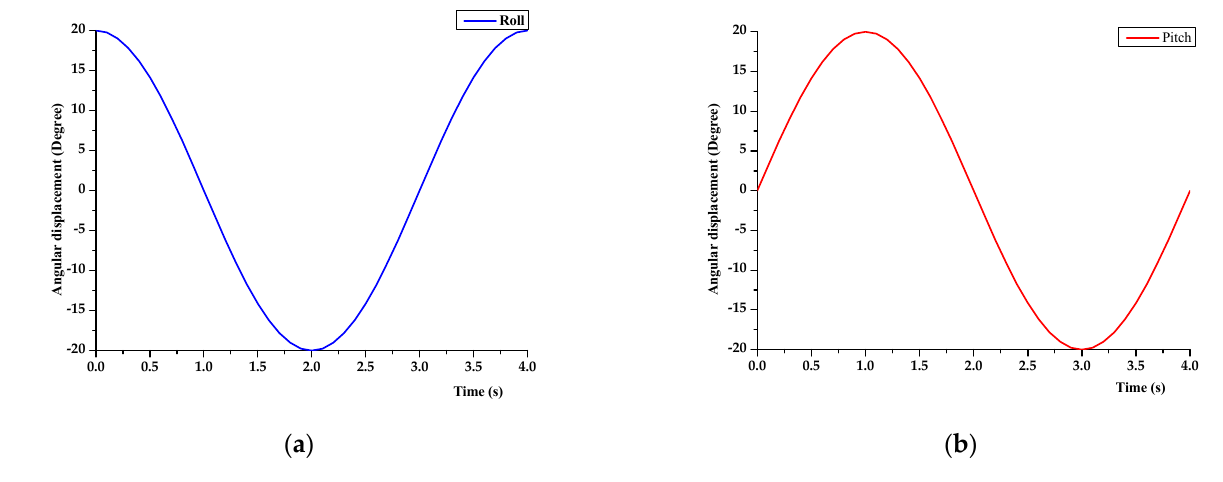
Figure 17. The trajectory of ( a ) roll ( b ) pitch. The trajectory of the crank and linkage positions of the roll and pitch motion were integrated and combined with the motor output angles of each action point to create a multi-axis motion platform trajectory model by Matlab, as shown in Figure 18. The maxi- mum upward motor output angle was 58.3°, the maximum downward angle was 58.6°, and the total stroke angle was about 117°, as shown in Figure 19. In addition, the maxi- mum motor output velocity was about 7.8 rpm, as shown in Figure 20.